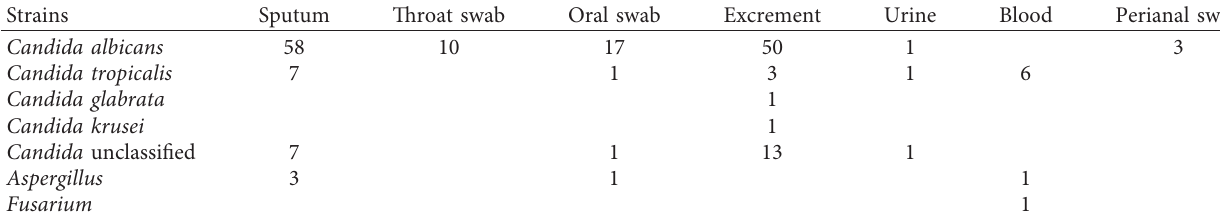
Table 3: Strains and distribution sites.